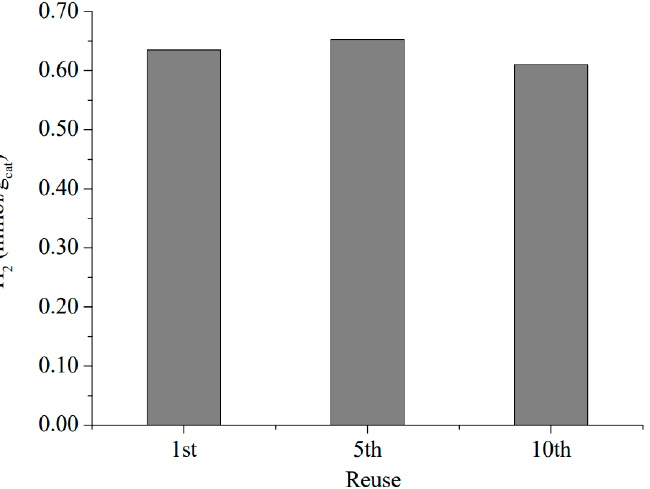
Figure 8. Reusability test of COP–3. For the sake of clarity, the figure shows the hydrogen generation in the first, fifth, and tenth reuse experiment of 6 h.